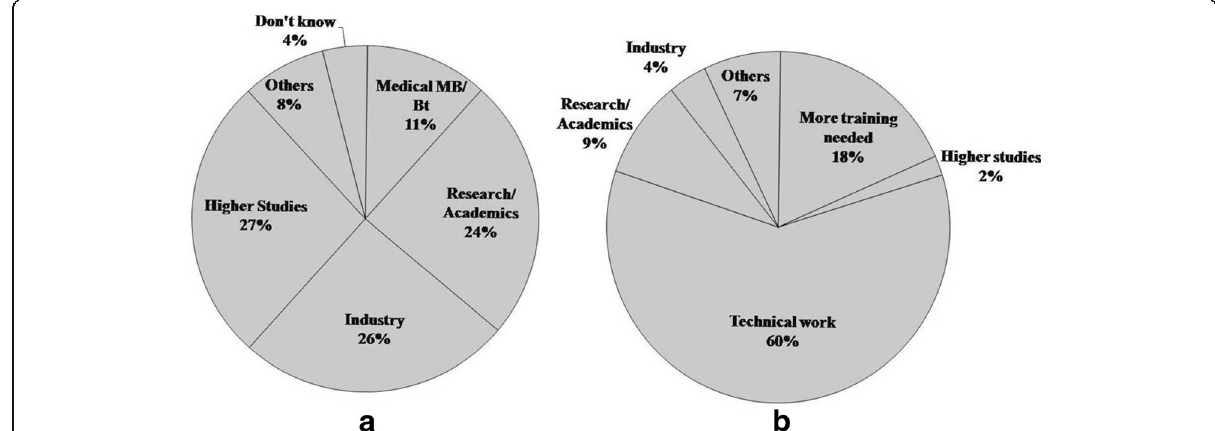
Fig. 4 a Students ’ ( n = 192) reported career choices. b Teachers ’ ( n = 55) report on career options suitable for students after the degree